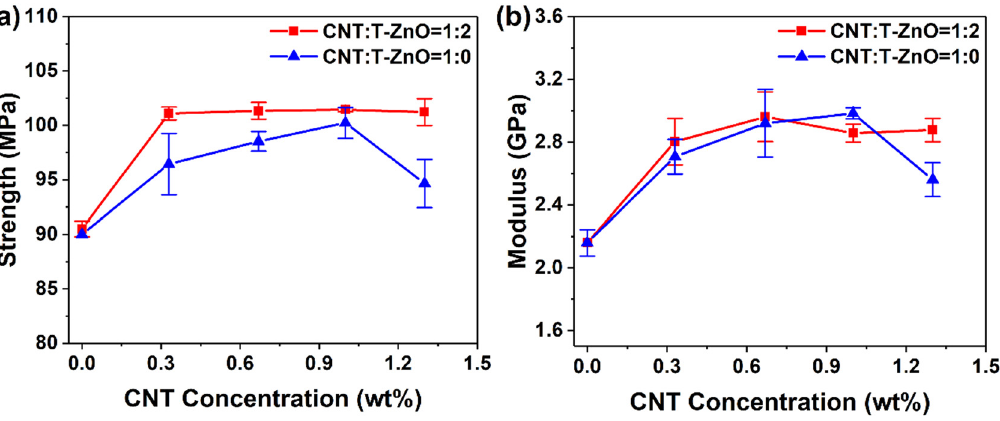
Figure 6: Possible mechanism of the manipulation e ff ect of T - ZnO in the network formation in the epoxy resin under di ff erent CNTs:T - ZnO ratios. ( a ) CNTs agglomerates reduced from T - ZnO. ( b ) CNTs:T - ZnO = 1:1. ( c ) CNTs:T - ZnO = 1:2. ( d ) CNTs:T - ZnO